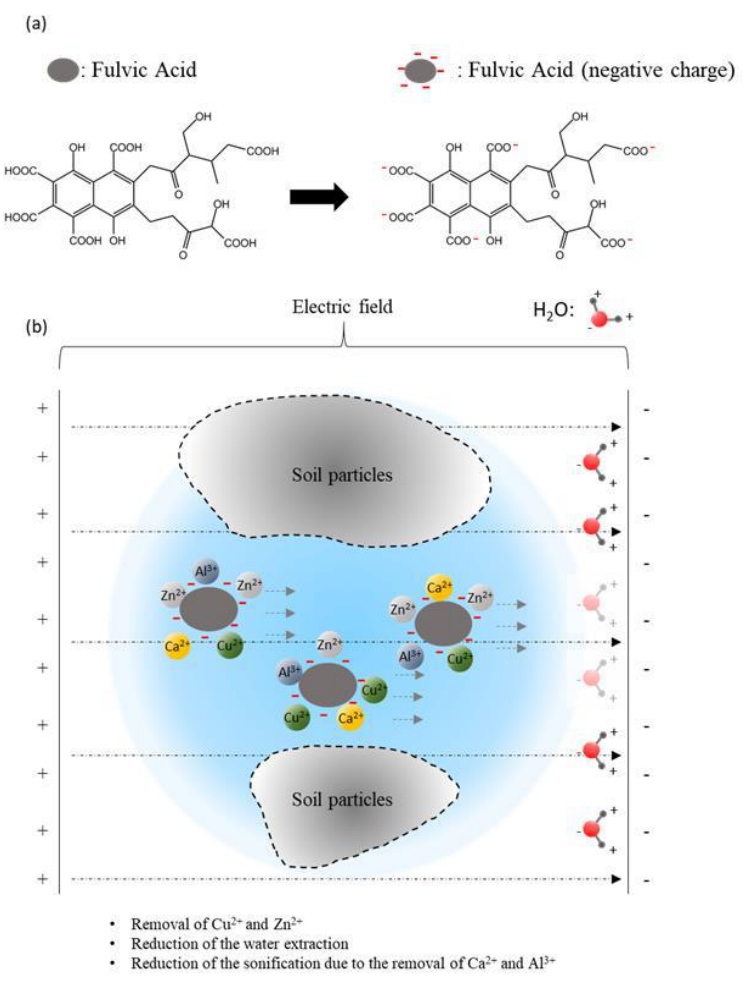
Figure 9. ( a ) The tendency of the negative charge of fulvic acid; ( b ) influence of the fluvic acid on the solidification of the sediment.